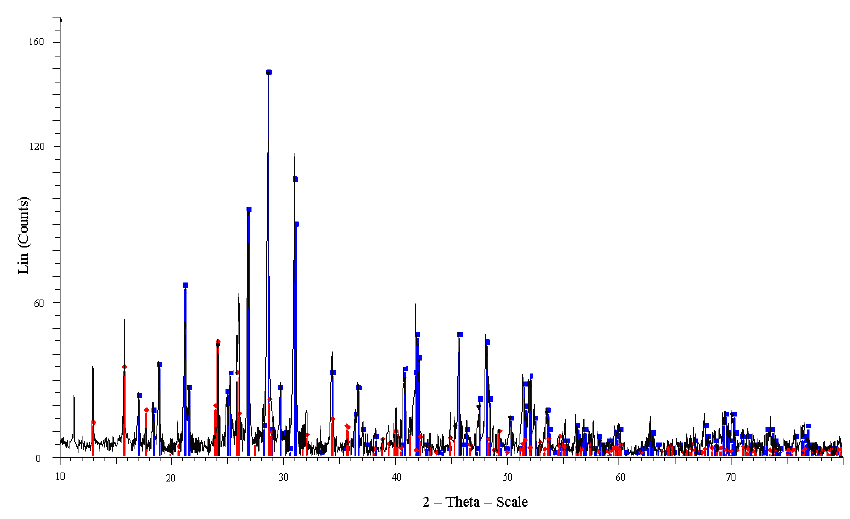
Fig. 6 X-ray diffraction pattern of sample Al 0 . 5 La 0 . 5 P 3 O 9